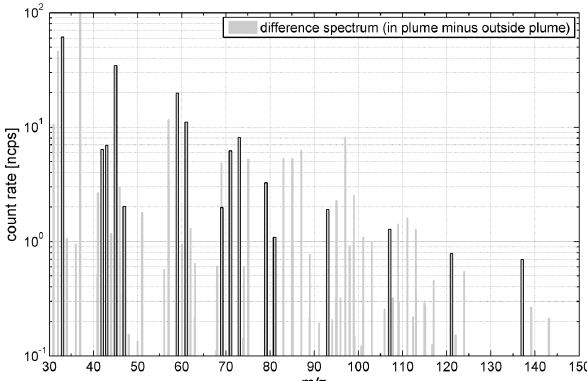
Figure 8. Full mass spectrum ( m/z 30–150) obtained during a 30s transect of an agricultural crop plume. The atmospheric background measured outside the plume has been subtracted from the in-plume data. The signals highlighted in dark grey indicate the signals that are typically recorded by conventional PTR-QMS. The signals in light grey are unidentified organic compounds (with the exception of m/z 32, 36 and 37).